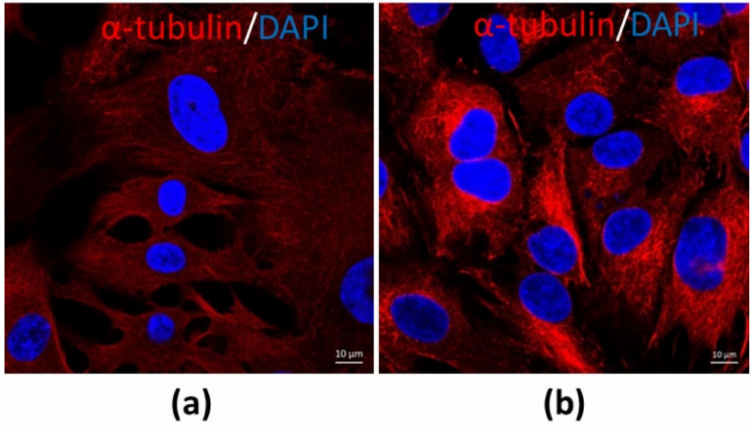
Figure 2. The morphological differences between MGCs and CCs. ( a ) MGCs at 63 × magnifica- tion; ( b ) CCs at 63 × magnification. The cells were stained by the immunofluorescence method (unpublished